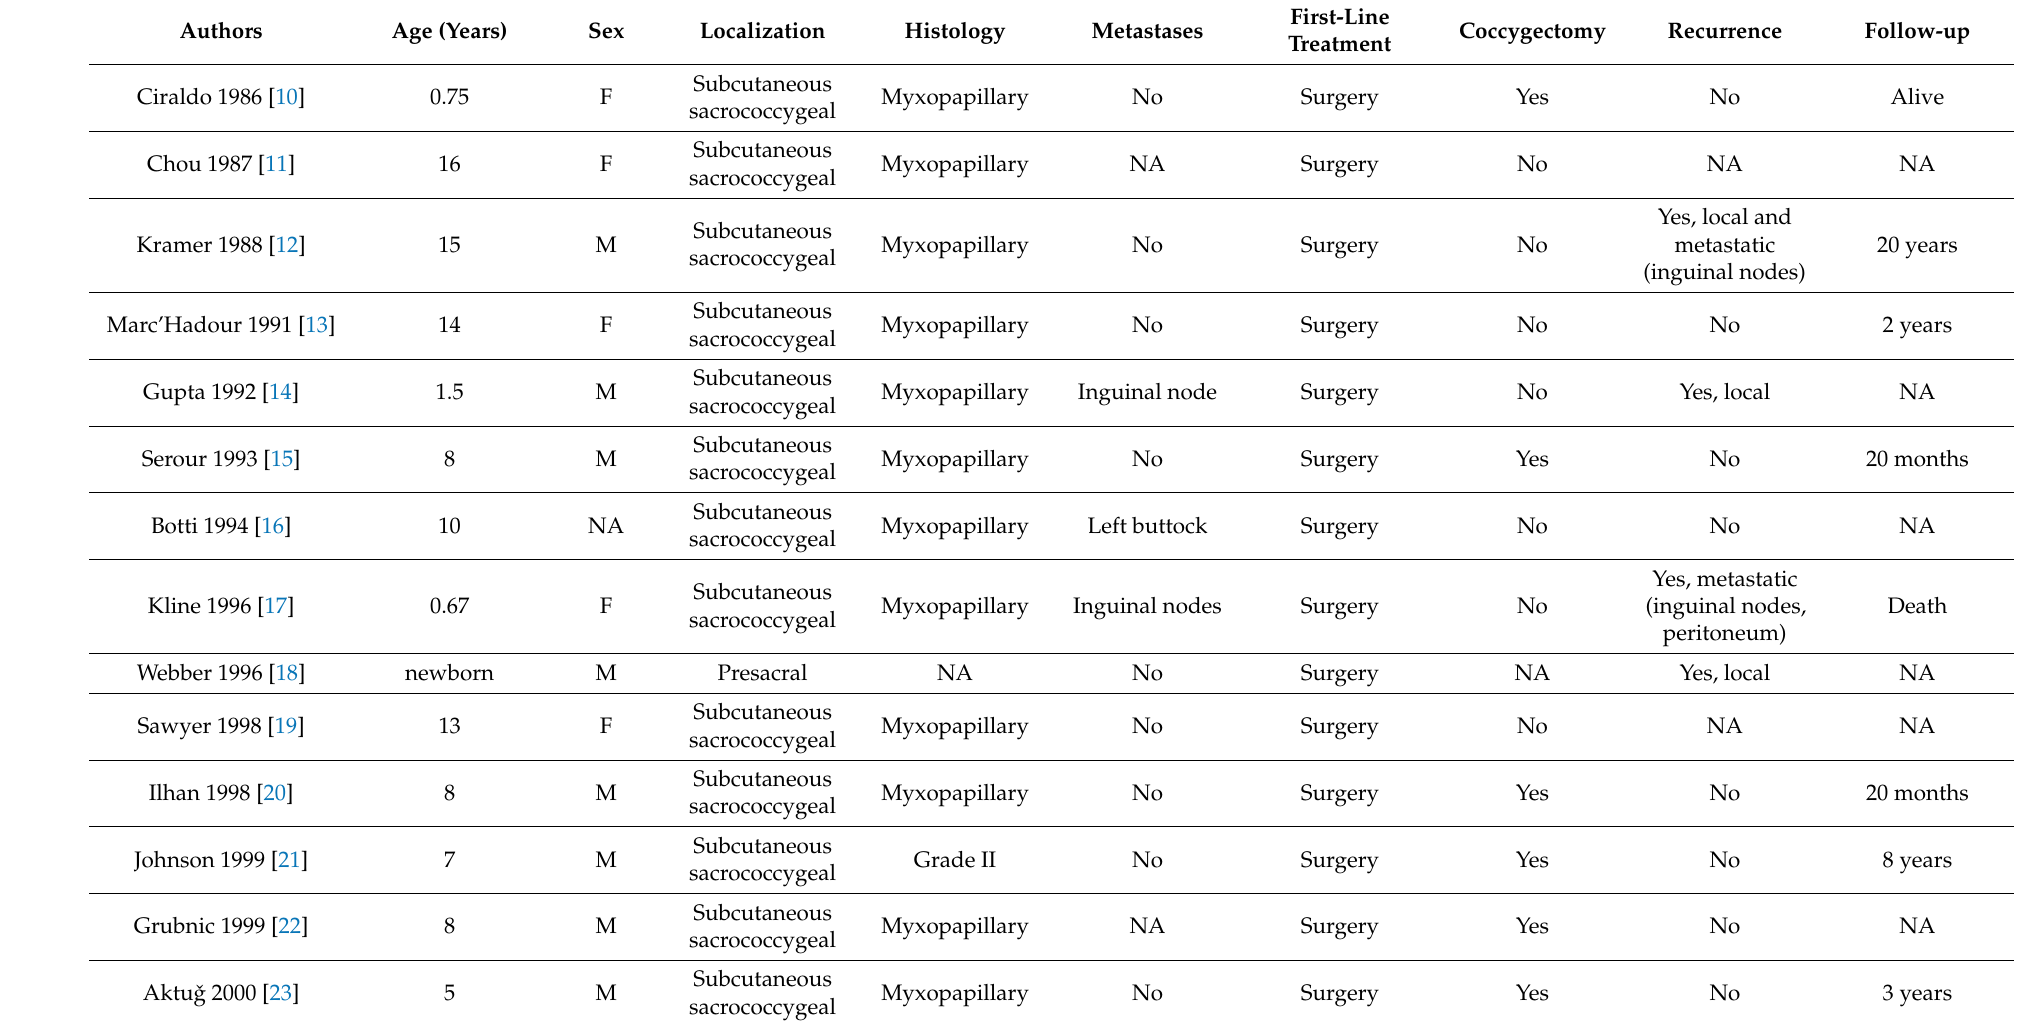
Table 1. Extra SNC ependymomas occurring in children during the last 35